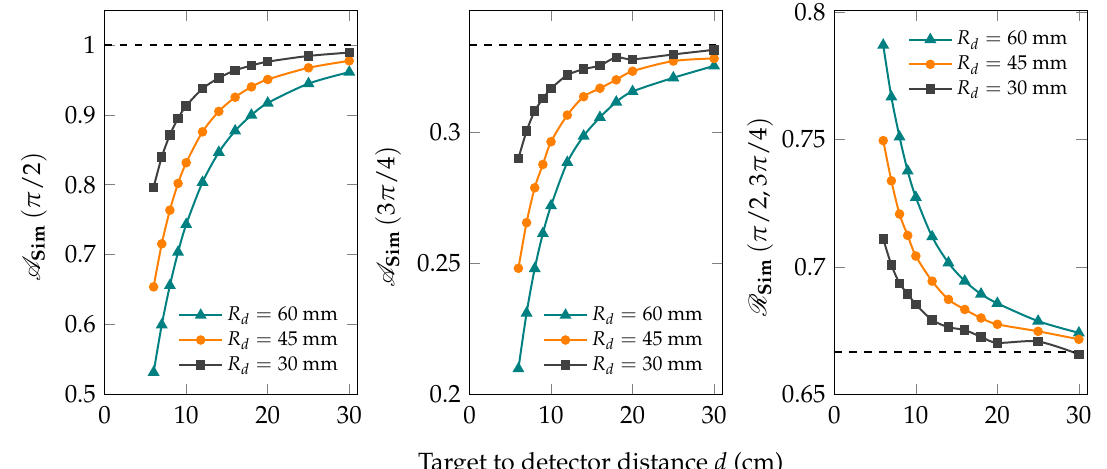
Figure 4. Dependence of the asymmetries A Sim ( π /2 ) and A Sim ( 3 π /4 ) , and the angular distribution ratios R Sim ( π /2,3 π /4 ) on the target-to-detector distance at different detector radii for the dipole transition with a spin sequence of 0 → 1 → 0, while λ t = 10 mm and R t = 5 mm. The exact values corresponding to the point target and point detector are expressed by dashed